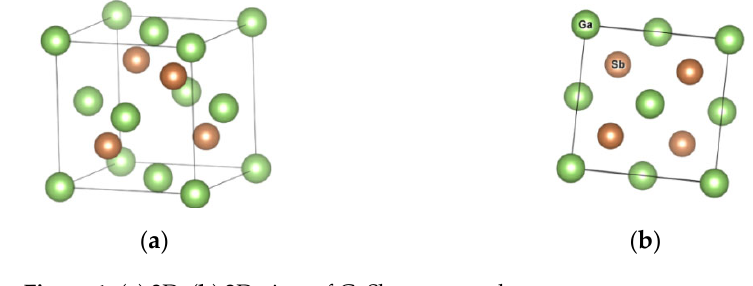
Figure 1. ( a ) 3D, ( b )2D view of GaSbcompound.